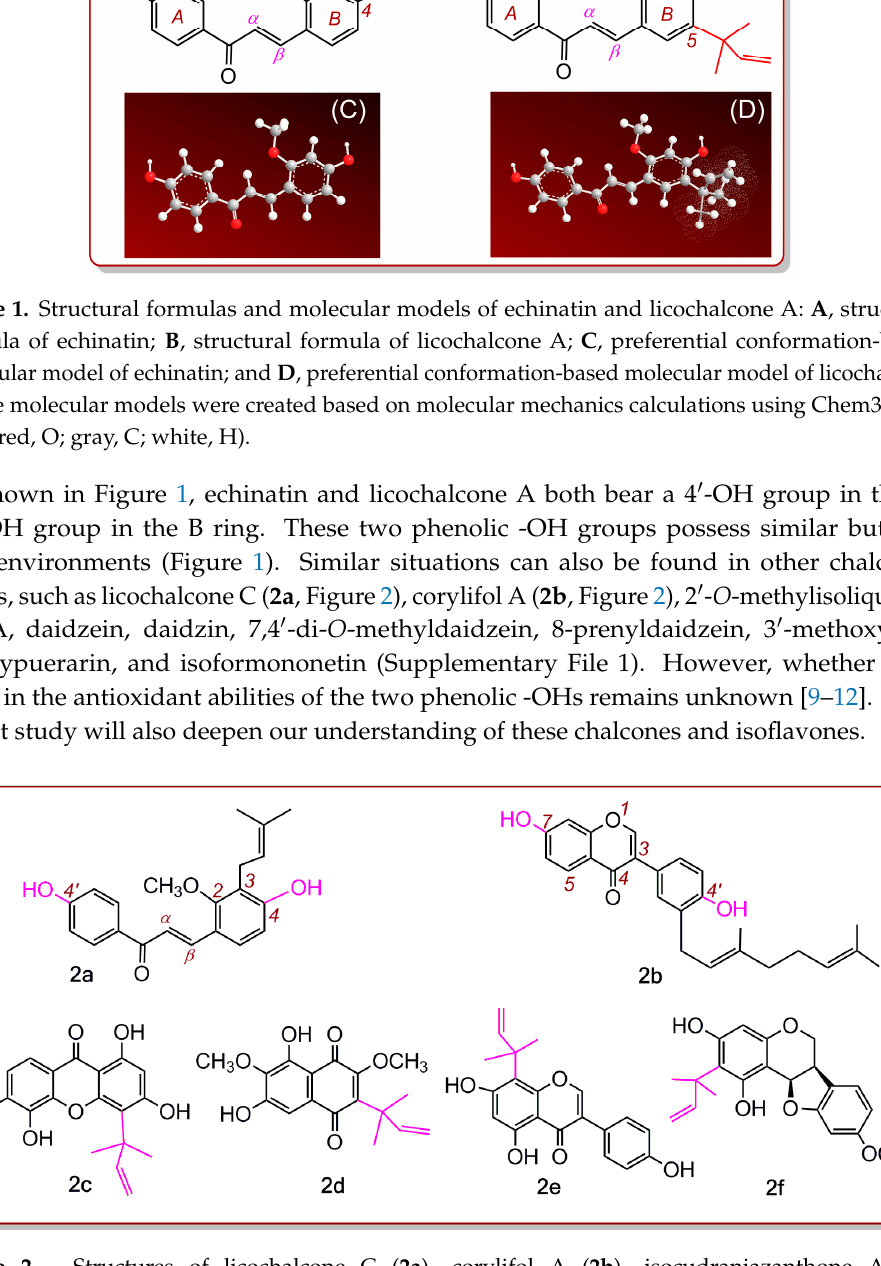
Figure 2. Structures of licochalcone C ( 2a ), corylifol A ( 2b ), isocudraniazanthone A ( 2c ), 6,8-dihydroxy-2,7-dimethoxy-3-(1,1-dimethylprop-2-enyl)-1,4-naphthoquinone ( 2d ), 5,7,4 ′ -trihydroxy-8- (1,1-dimethylprop-2-enyl) isoflavone ( 2e ), and glycyuralin B ( 2f ).